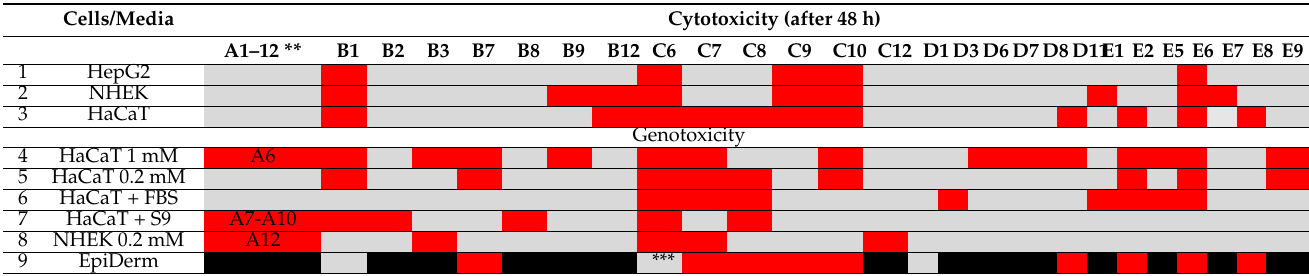
Table 1. Cytotoxicity and genotoxicity of compounds in 2D and 3D *.